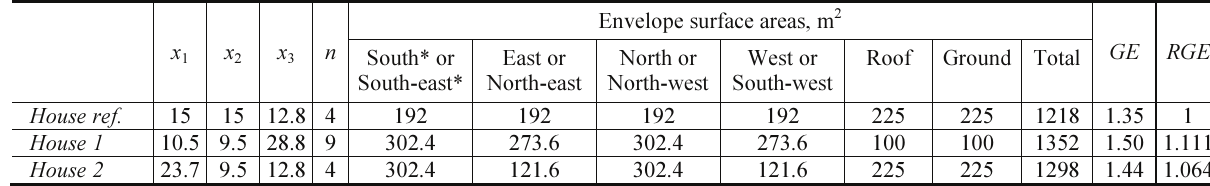
Envelope surface areas, m 2